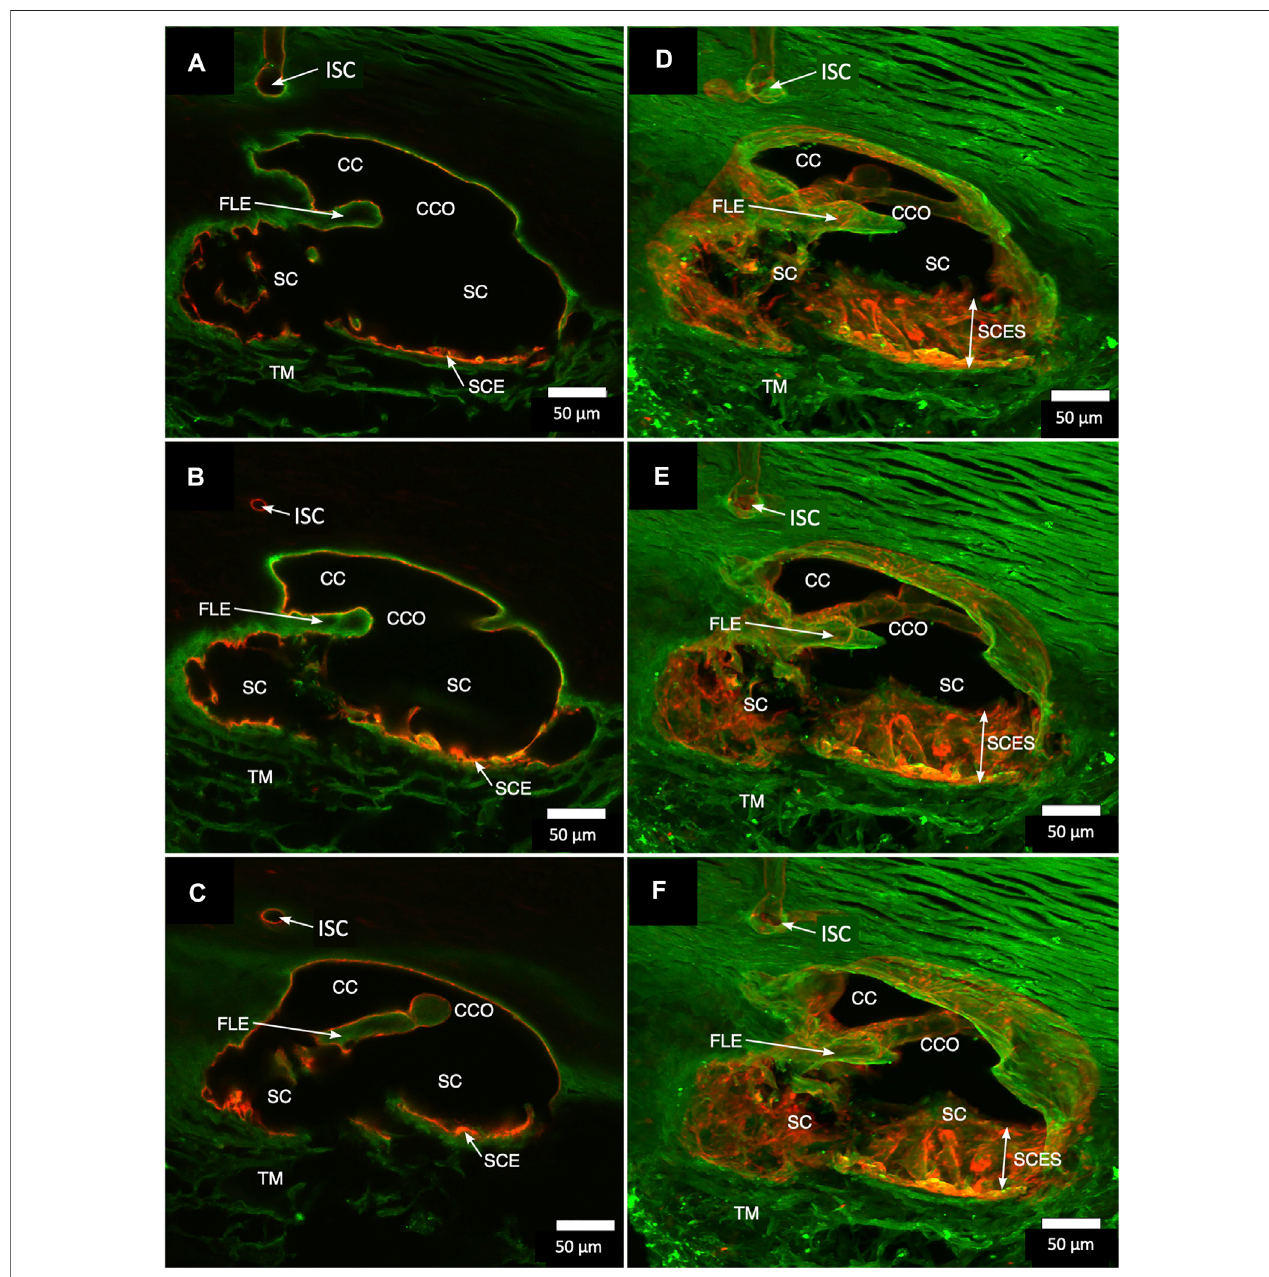
FIGURE 2 | Projections display Schlemm ’ s canal fl ap-like collagenous extensions at collector channels. (A – C) are 2D while (D – F) are 3D projections of a 129-µm stackofmerged CD31(red) andCol type1(green) images. Viscodilation ofSchlemm ’ scanal(SC), clari fi cation, and deep stackprojectionscharacterizetheorganization and relationshipsoftissues surrounding collectorchannels(CCs) and theirostia (CCO). Flap-likecollagenous extensions (FLE)from thesclera wallprotrudeintoSC.The distalendoftheFLEisnotanchored,thusprovidingahingedcon fi guration.TheFLE,CCO,andCCrelationshipsarenoteasilyconceptualizedinthe2Dimagesbut become evident in 3D projections. TM is a trabecular meshwork #39RST13.